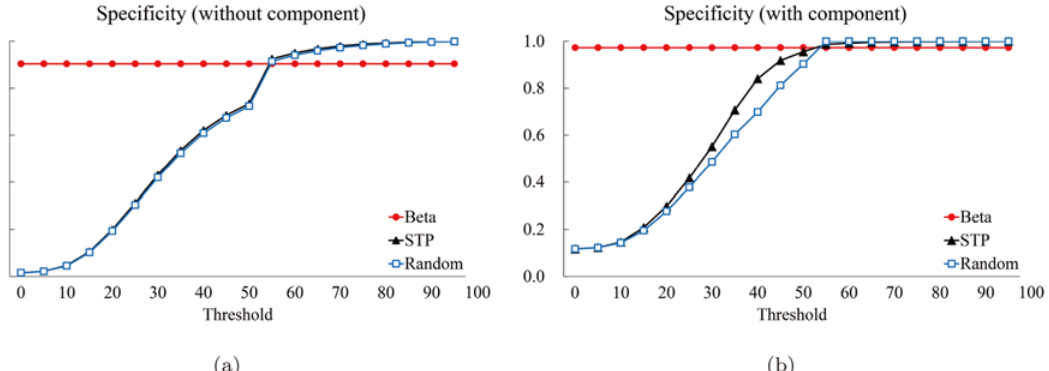
Fig 19. The specificity graphs. The red circle corresponds to the proposed method. The black triangle and blue square correspond to the average value (of the 85 structures of the Astex Diverse Set) for the STP and Random methods for each threshold value, respectively. The horizontal and the vertical axes denote the thresholds and the computed values of specificity, respectively. (a) Specificity for “ Without (component) ” and (b) one for “ With (component). ”